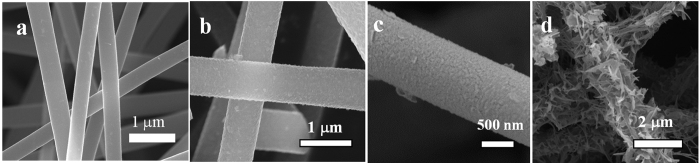
SEM images of the external surface of MnO2/CNFs composites (a) MC0, (b) MC1, (c) MC2 and (d) MC10.